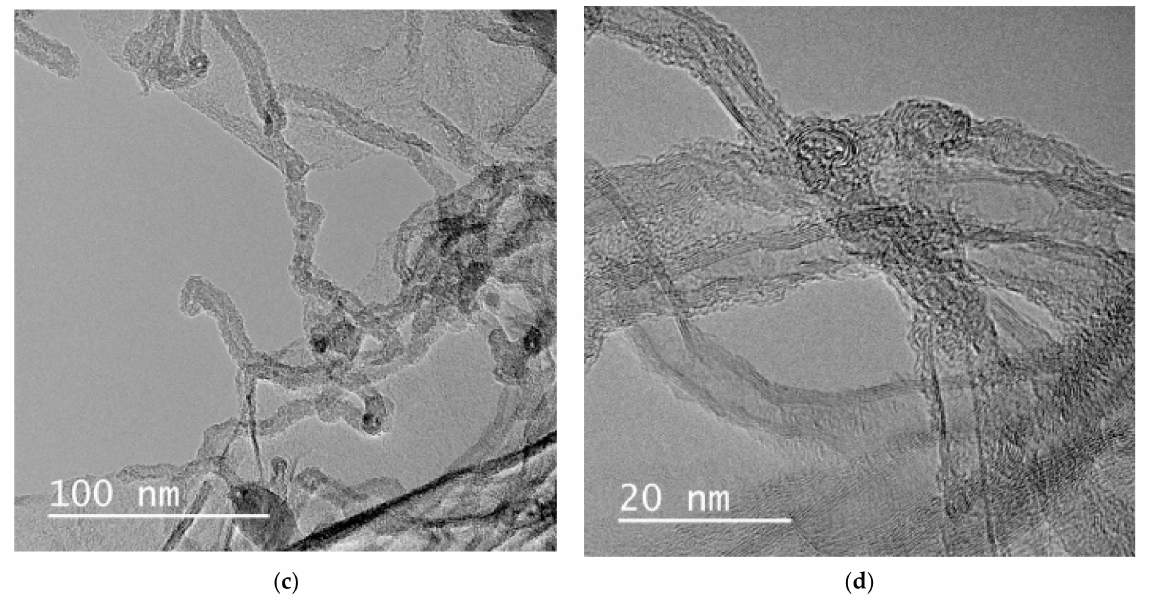
Figure 1. SEM ( a , b ) and TEM ( c , d ) image of the surface of the nanocomposite cryogel.